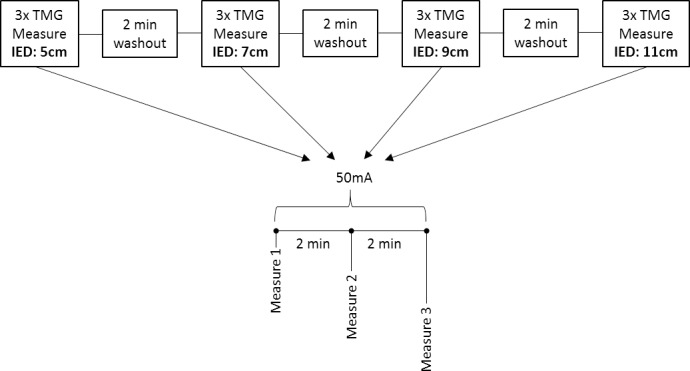
Experiment 3 timeline.The effect of changing inter-electrode distance on Dm and Tc. Abbreviation: IED, inter-electrode distance.